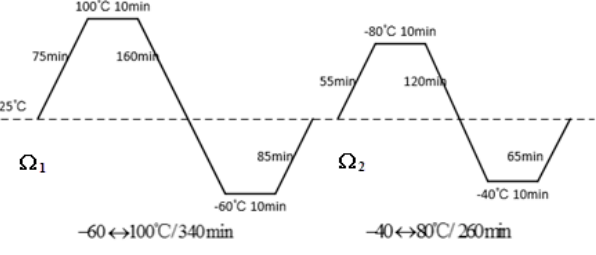
Figure 7. Thermal load profiles of Ω 1 and Ω 2 Figure 7. Thermal load profiles of Figure 7. Thermal load profiles of